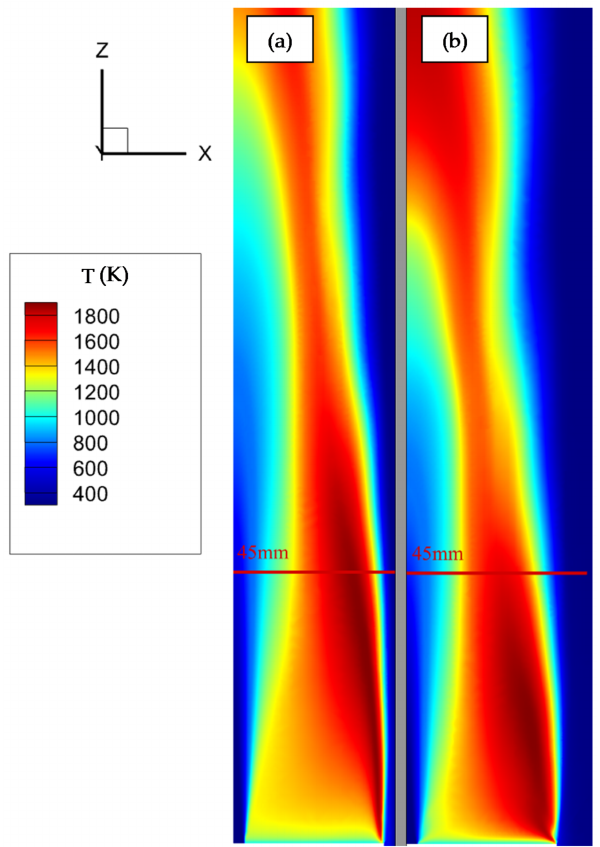
Figure 13. Temperature contours. ( a ) Standard wall function. ( b ) Enhanced wall